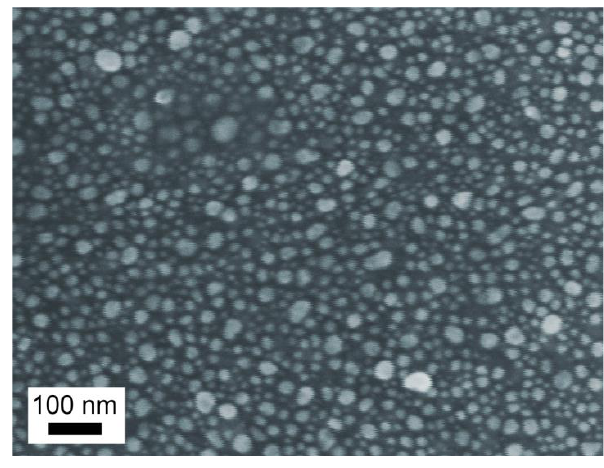
Figure 1. SEM image of the prepared SNF. Ala and Ser (pure grade, Reakhim, Moscow, Russia) in the form of both powders (crystallites) and 1 mM solutions in PBS, pH 7.4 (Biolot, St. Petersburg, Russia),